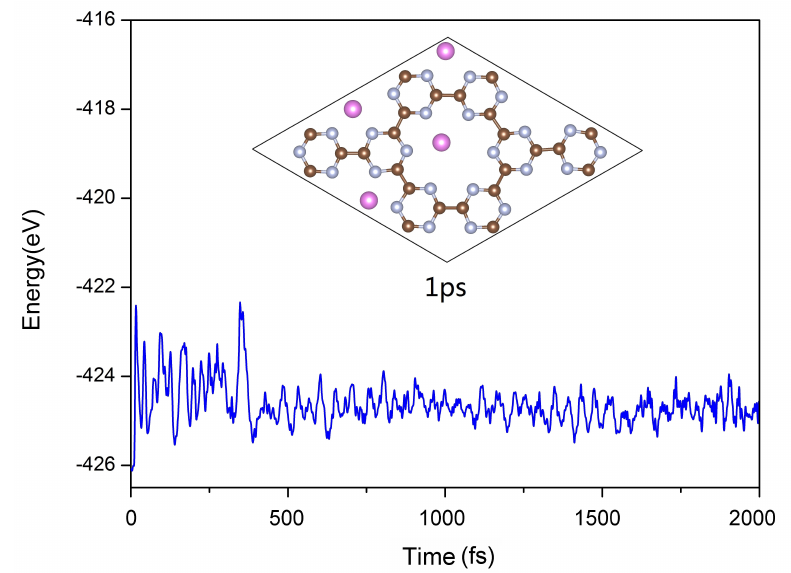
Figure 5. First − principles MD simulation of the Al-doped g-CN at a temperature of 300 K. The time step is set to 0.5